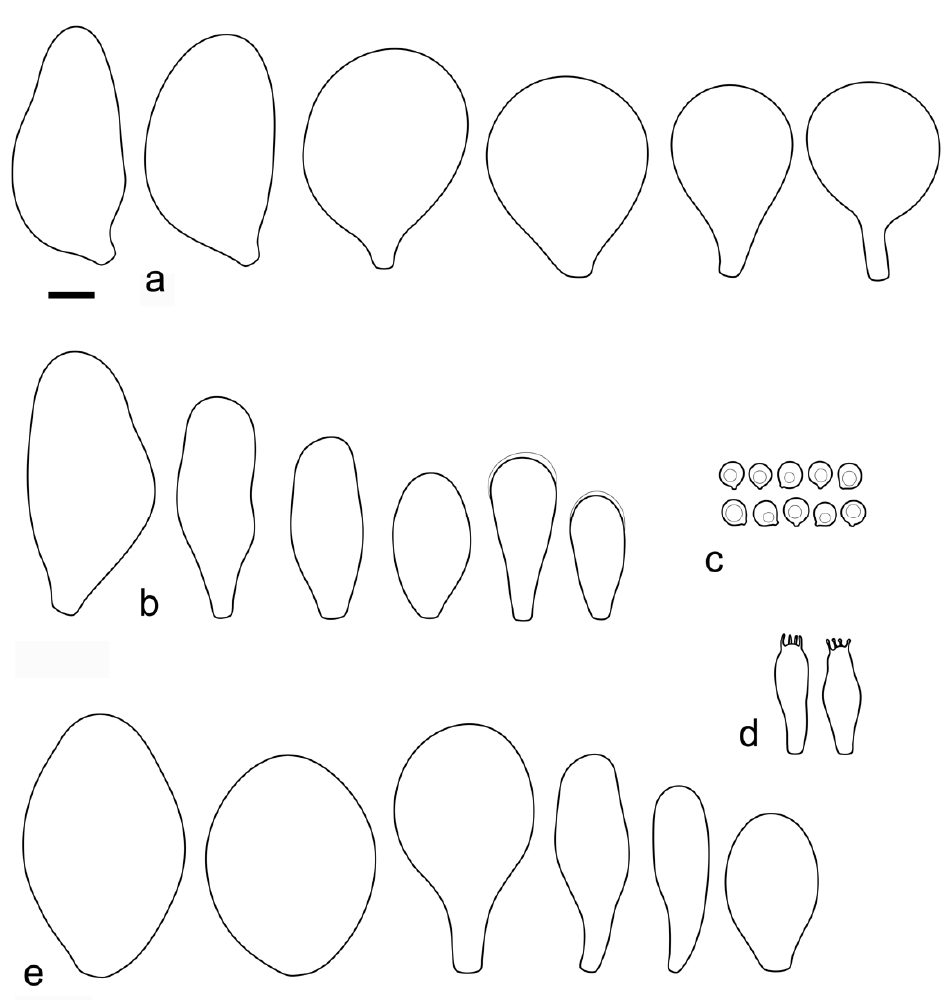
Figure 19. Pluteus siccus , holotype LE 313356: ( a ). pileipellis elements, ( b ). pleurocystidia, ( c ). basidiospores, ( d ). basidia, ( e ). cheilocystidia. Scale bar 10 µm.